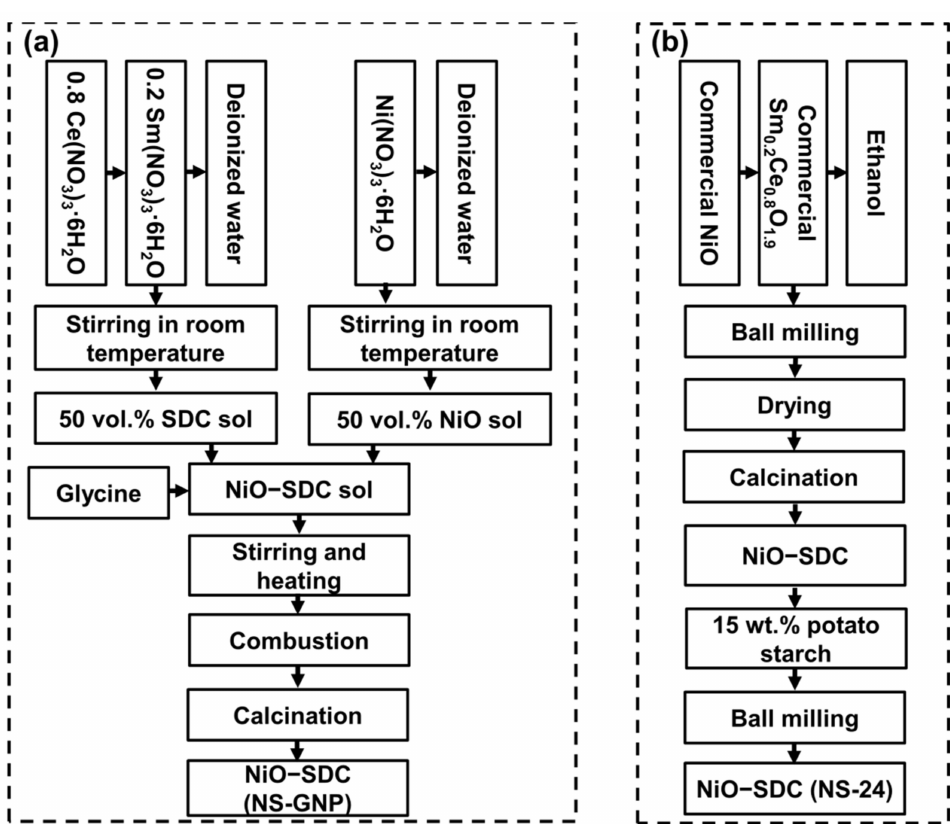
Figure 1. Flow chart for the synthesis of NiO–SDC composite anode powders using the: ( a ) glycine–nitrate combustion process and ( b ) ball milling process.